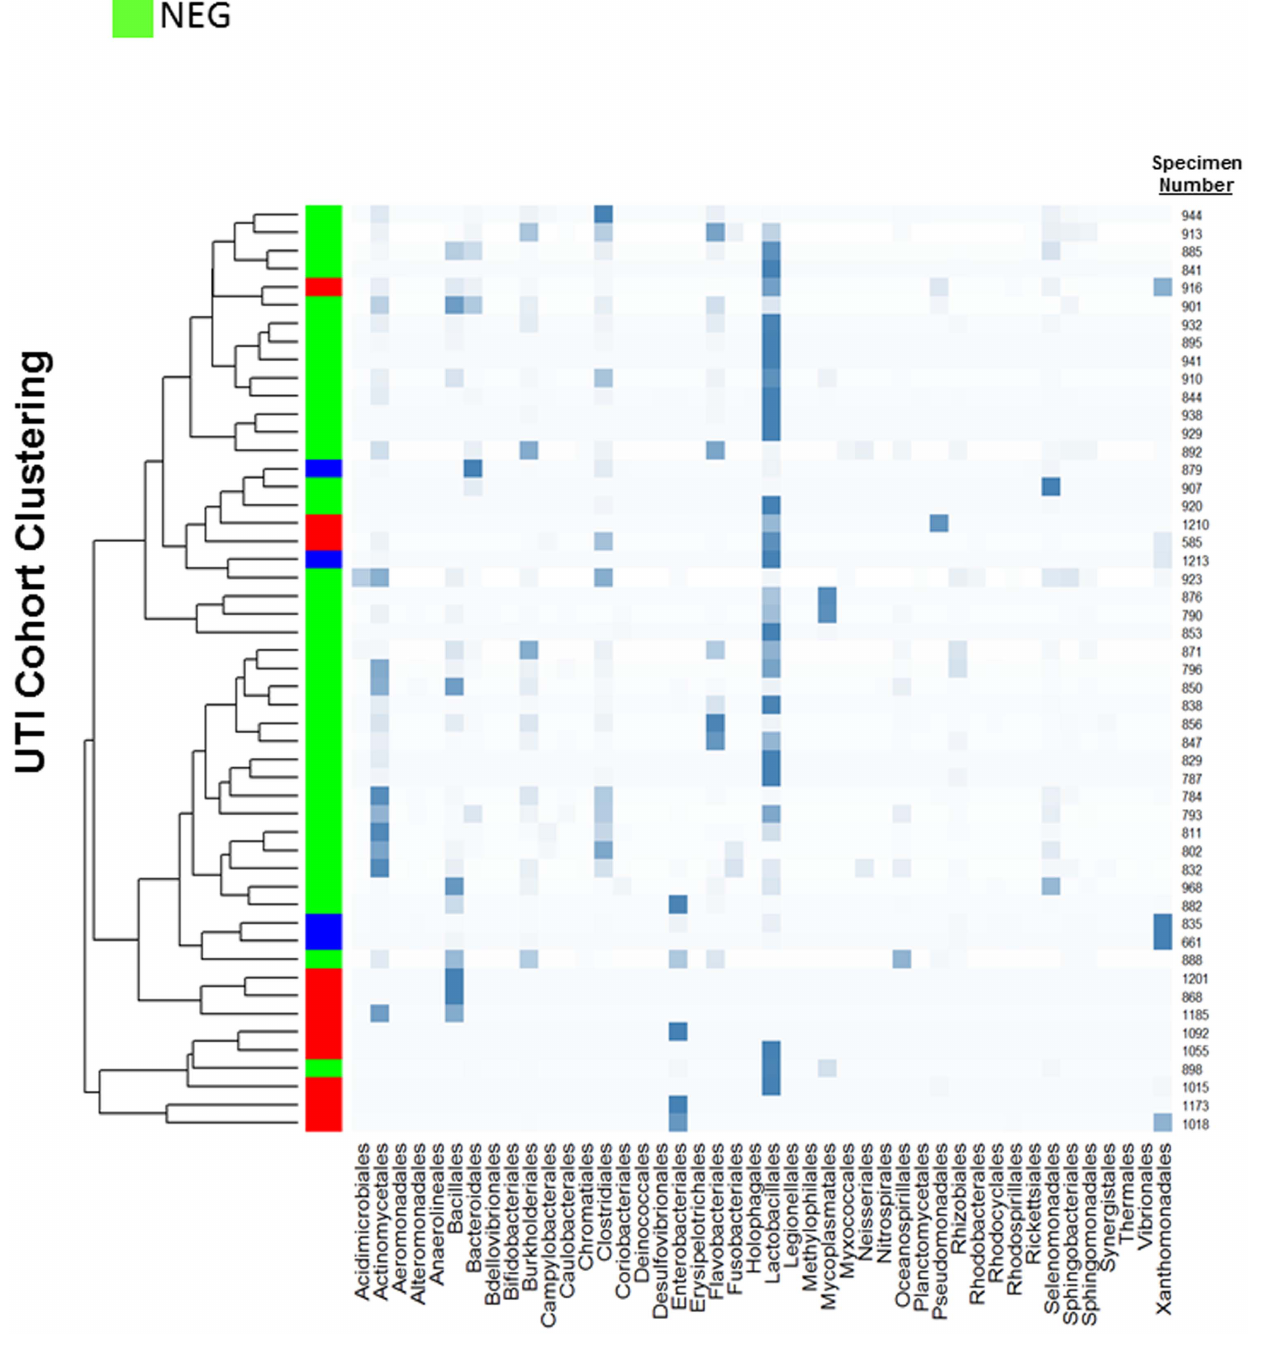
Fig. 2. Bacterial abundance and phylogenetic similarity distinguishes the three UTI cohorts. Heatmap representing urine specimens clustered according to their phylogenetic similarities. The abundance of each bacterial Order is represented by the blue boxes, with greater abundance indicated by darker blue squares. Y-axis: Dendogram based on phylogenetic similarities. X-axis: Order. POS (Blue), PostI-UTI (Red) and NEG (Green).